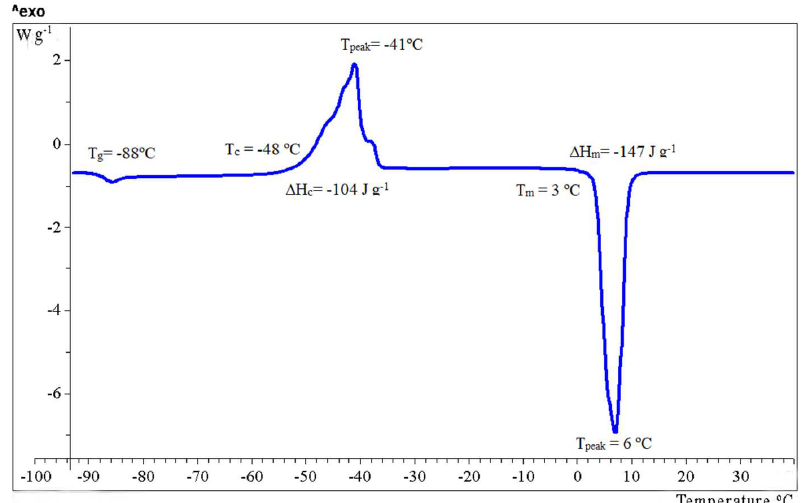
Figure 2. Low-temperature DSC plot of azide 6